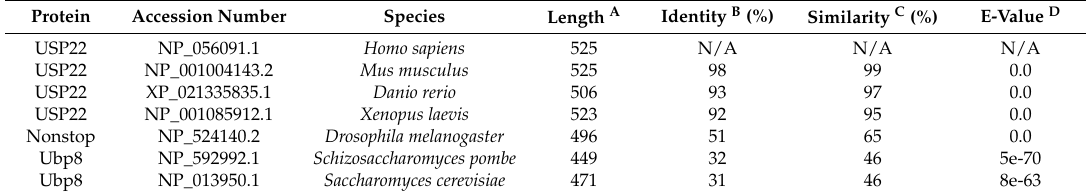
Table 1. USP22 is an evolutionarily-conserved histone deubiquitinase